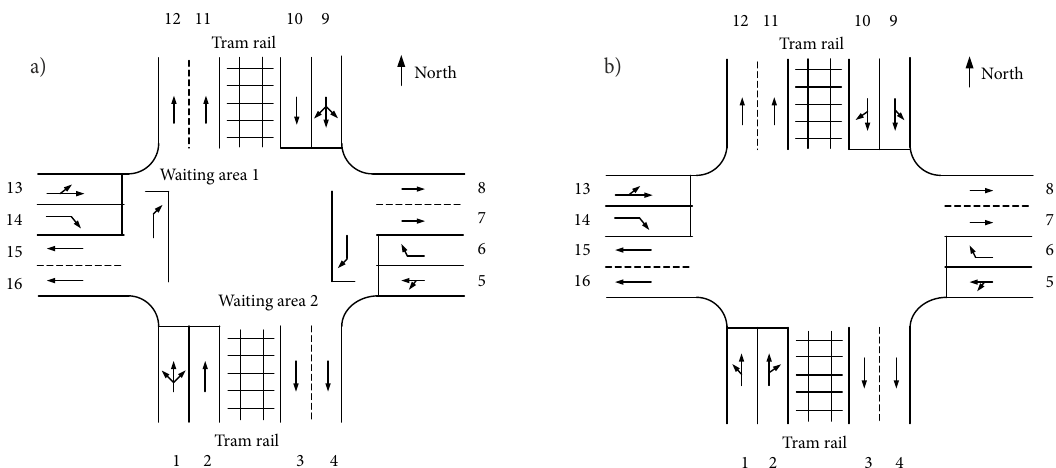
Fig. 1. Comparison of a hook-turn intersection and traditional intersection: a – intersection with HT; b – traditional intersection